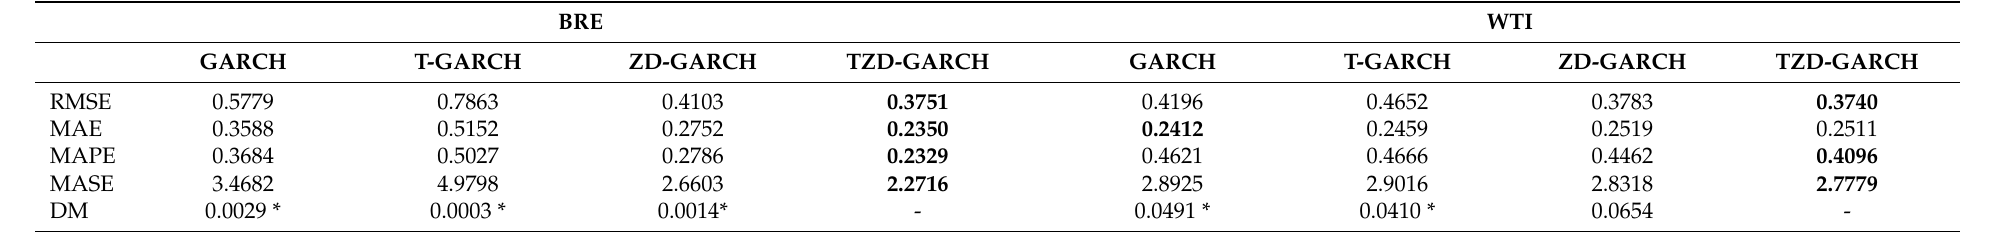
Table 5. Out-of-sample forecasting results (2018–2019): BRE and